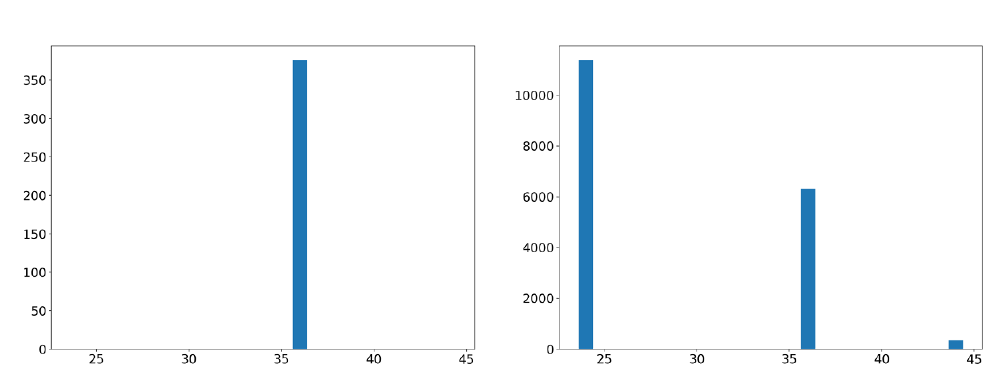
Figure 5 . The histograms of c 2 ; 2 for the 3-generation island in the left panel and all region in the right panel. The axes are the same as (cid:12)gure 4.